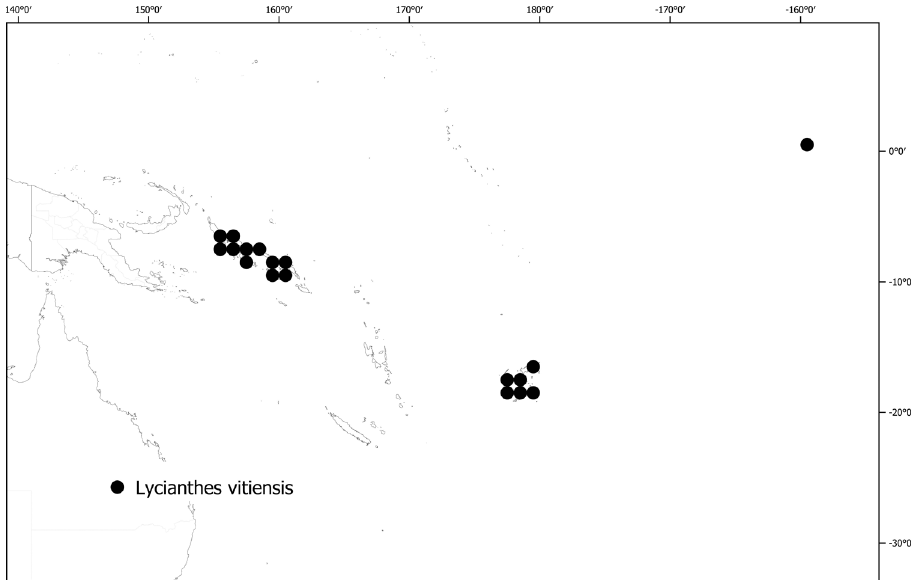
Figure 53. Distribution of Lycianthes vitiensis